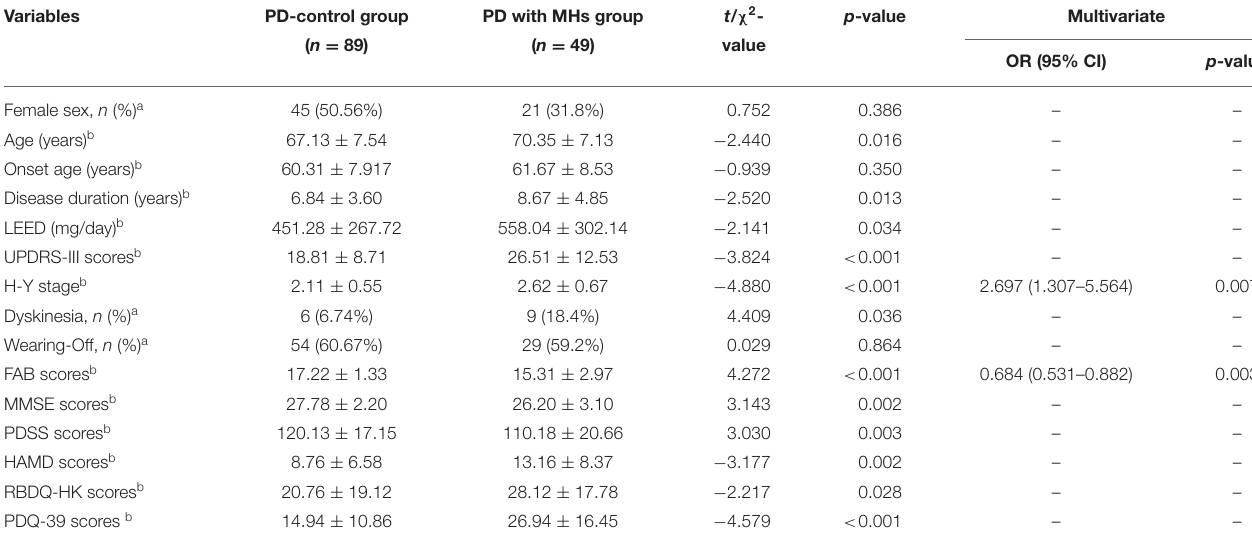
TABLE 2 | Logistic regression analyses of the factors associated with minor hallucinations. Variables